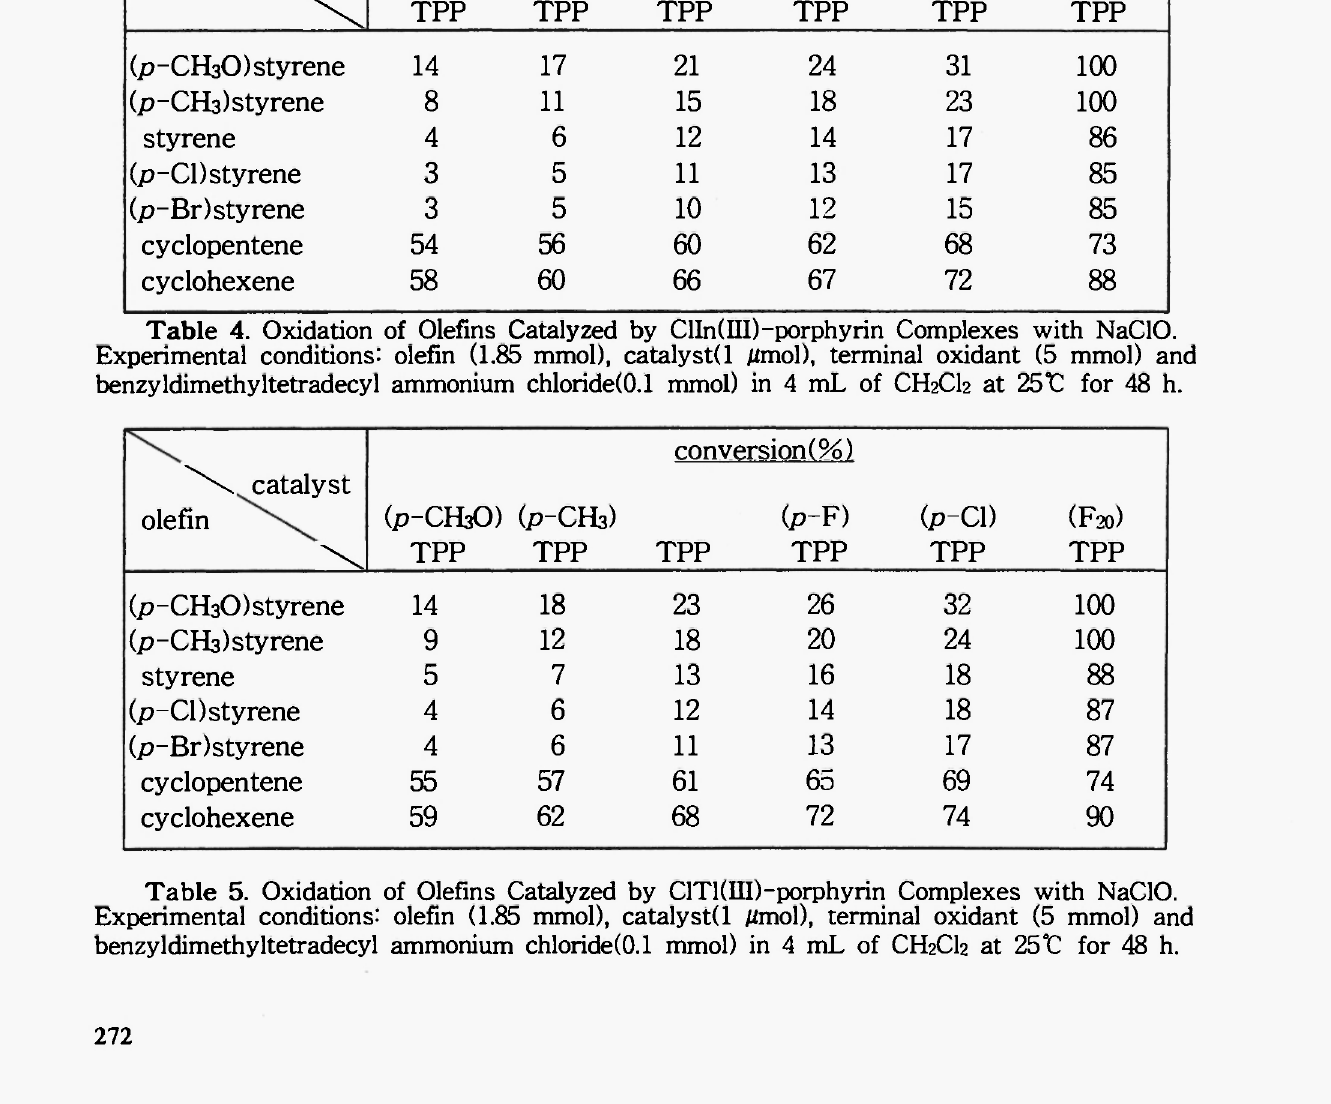
Table 5. Oxidation of Olefins Catalyzed by ClTl (HI )-porphyrin Complexes with NaClO. Experimental conditions: olefin (1.85 mmol), catalystü /imol), terminal oxidant (5 mmol)